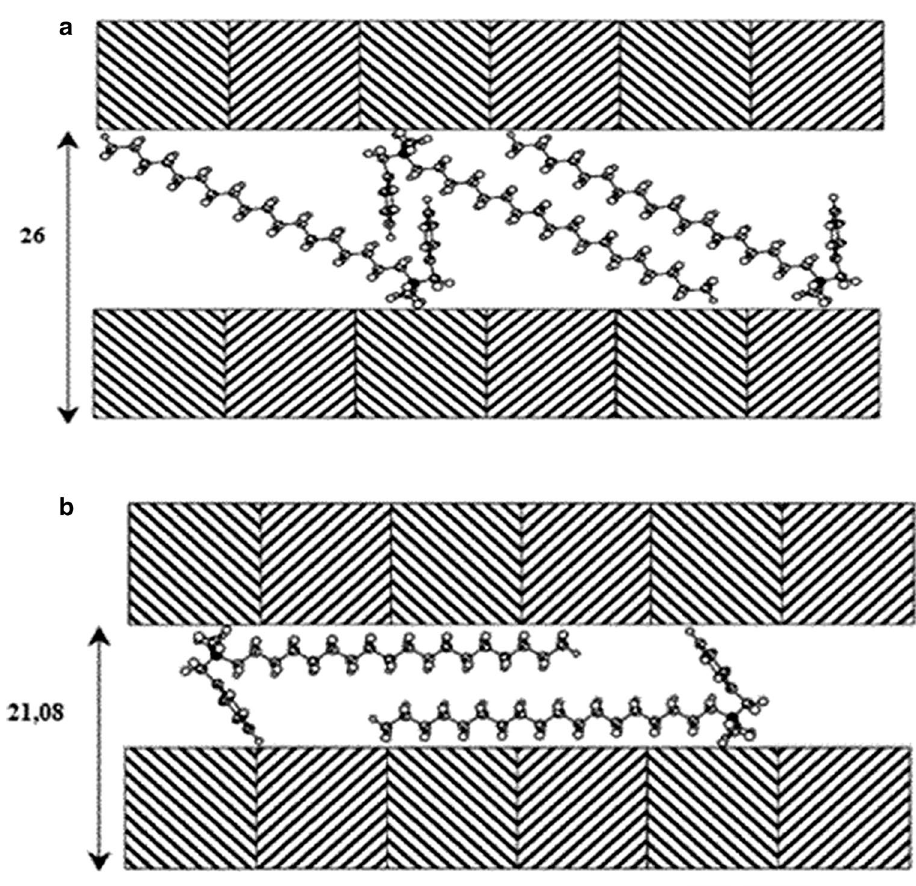
Fig. 7 Representation of modi- fied smectite arrangements by HDTMA ( a ) and HDPy ( b ). The lateral distances between the alkylammonium units are inversely related to the charge density of the